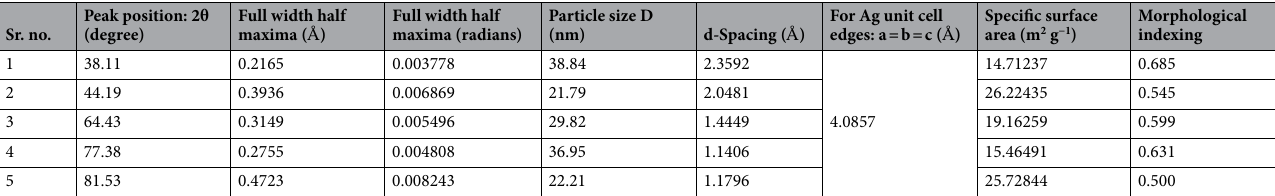
Table 1. Analysis and calculation of various parameters.